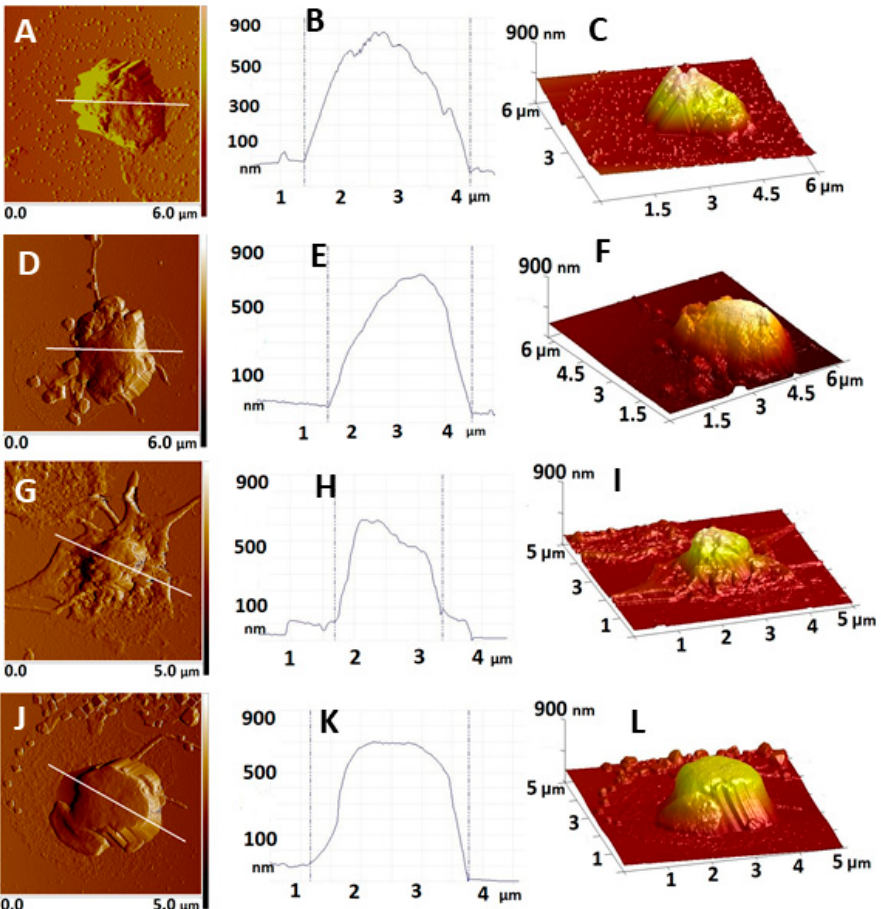
Figure 1. Representative 2D AFM images of platelets derived from control non-pregnant ( A ) and pregnant ( D ) women and women with early pregnancy loss EPL1 ( G ) embryonic stage of gestational development and EPL2 ( J ) placentation stage of gestational development; cross-section plot profiles ( B,E,H,K ) corresponding to the white lines in A , D , G , J ; 3D topographical images of the images in A , D , G and J , respectively ( C,F,I,L ). The images were taken in tapping mode in air, at room temperature.